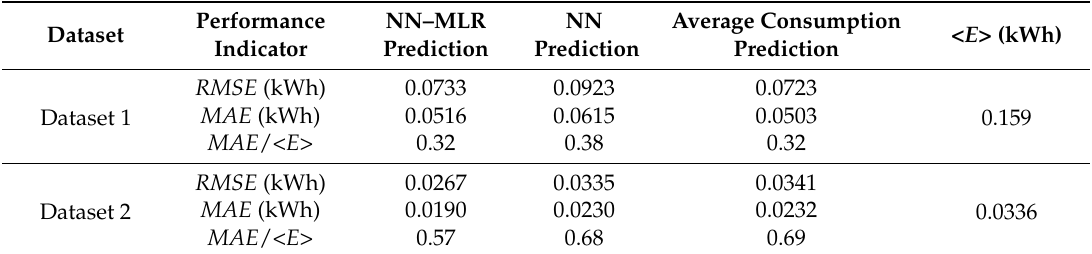
Table 4. Performance indicators for the energy prediction model and the two benchmark models for comparison on segment level. RMSE : root-mean-square error; MAE : mean absolute error; < E >: average consumed energy per segment.